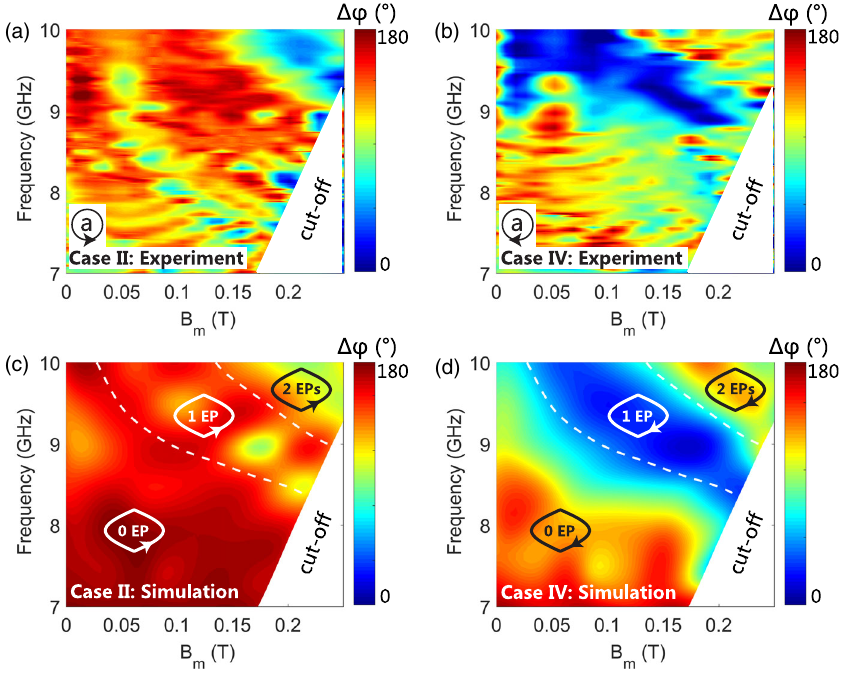
FIG. 6. (a), (b) Experimentally measured phase differences Δ φ at various bias fields B (c), (d) Numerically simulated phase differences Δ φ as a function of the bias field B